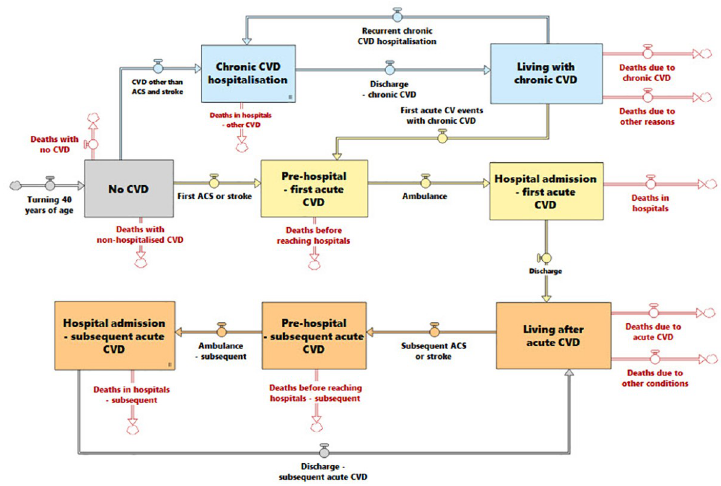
Fig 1. Simplified graphic representation of the model structure. ACS = acute coronary syndrome, CVD = cardiovascular disease.